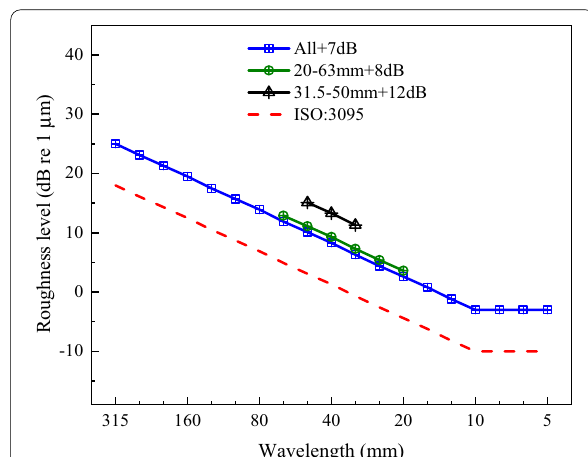
Figure 12 Effect of rail corrugation on interior noise: ( a ) overall and ( b ) frequency spectrum Figure 13 Rail roughness acceptance criteria at 60